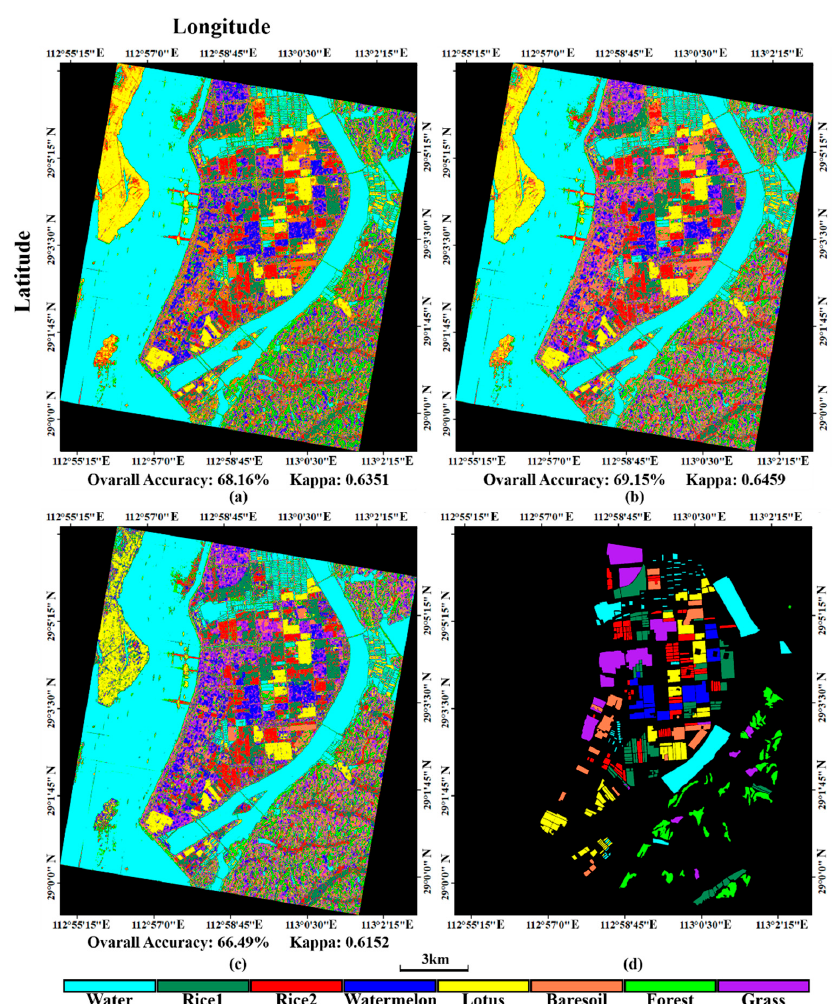
Figure 12. The classification results of different polarimetric classification methods. ( a ) the Wishart supervised classification with 𝐶 (cid:2871) ; ( b ) the SVM classification with 𝜎⃑ and ( c ) the SVM classification with the first two PCA components of 𝜎⃑ ; ( d ) the testing sample.